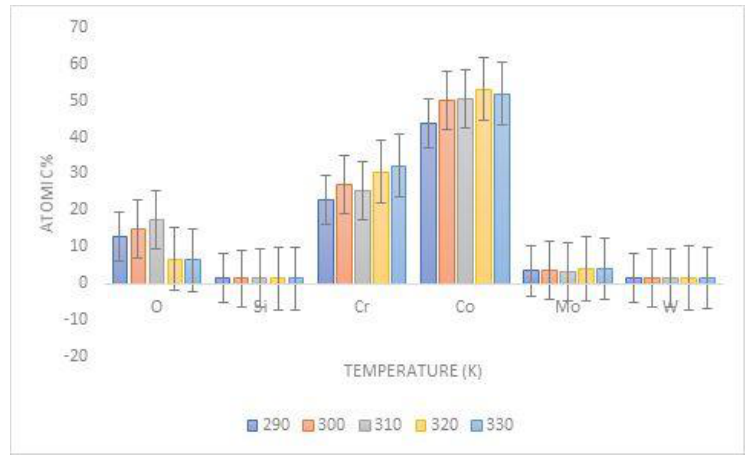
Figure 12. Elemental analysis for CoCr alloys after exposure in artificial saliva at different temperatures.